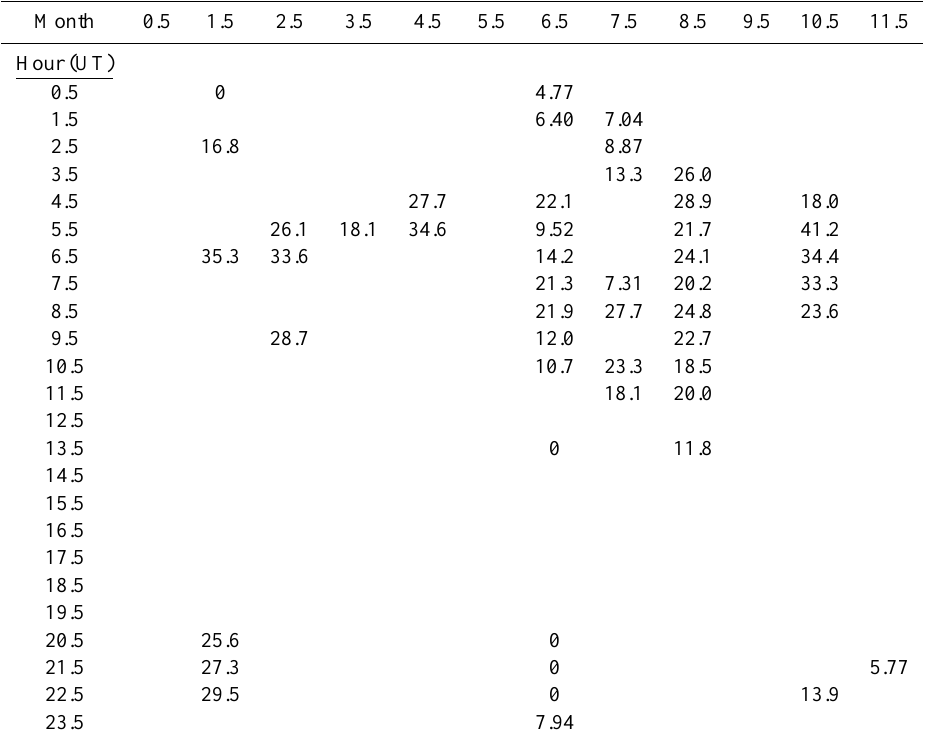
Table A4. Median Electron density at 85km for 1dB